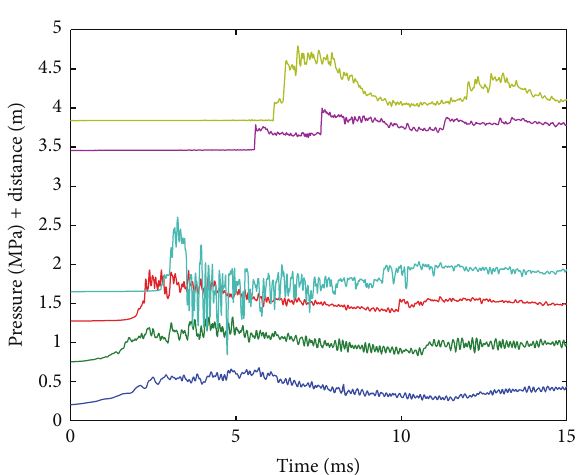
Figure 7: Pressure records from the stoichiometric NG-air mixture (test 23). Channels 1–6 are shown from bottom to top. The pressure levels are offset, an amount equal to the distance (m) from the ignition